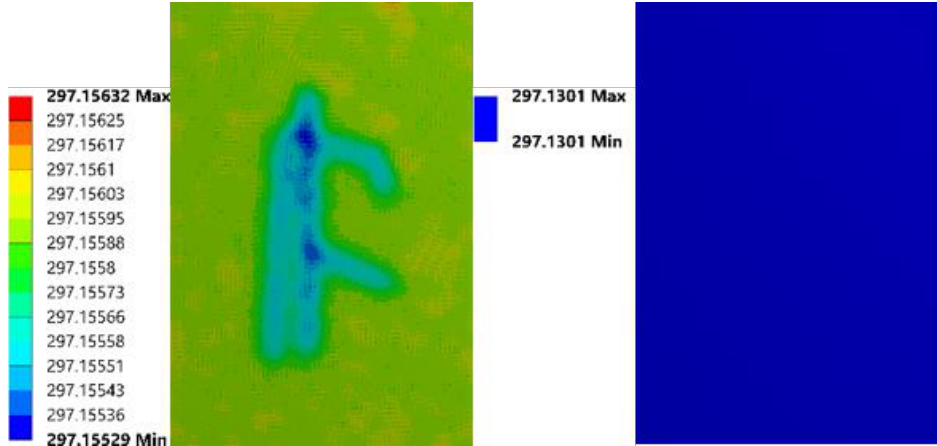
Figure 8. Simulation images of FEA model with 3 mm ( left ) and 4 mm ( right ) thick cover.